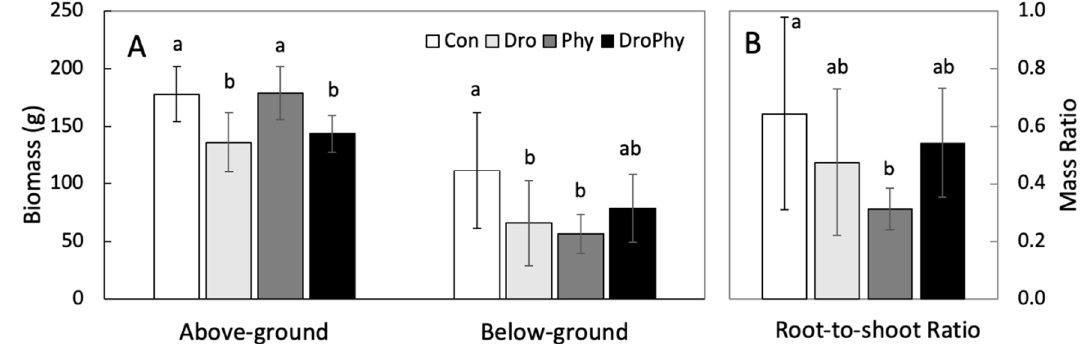
Figure 4. ( A ) Final above- and belowground biomass and ( B ) root-to-shoot ratio of E. obliqua seedlings subjected to Control (Con), Drought (Dro), Phytophthora (Phy), and Drought- Phytophthora (DroPhy) treatments. Error bars indicate ± standard error of the mean values. Means with different letters are significantly different at p ≤ 0.05, after ANOVA and LSD test.